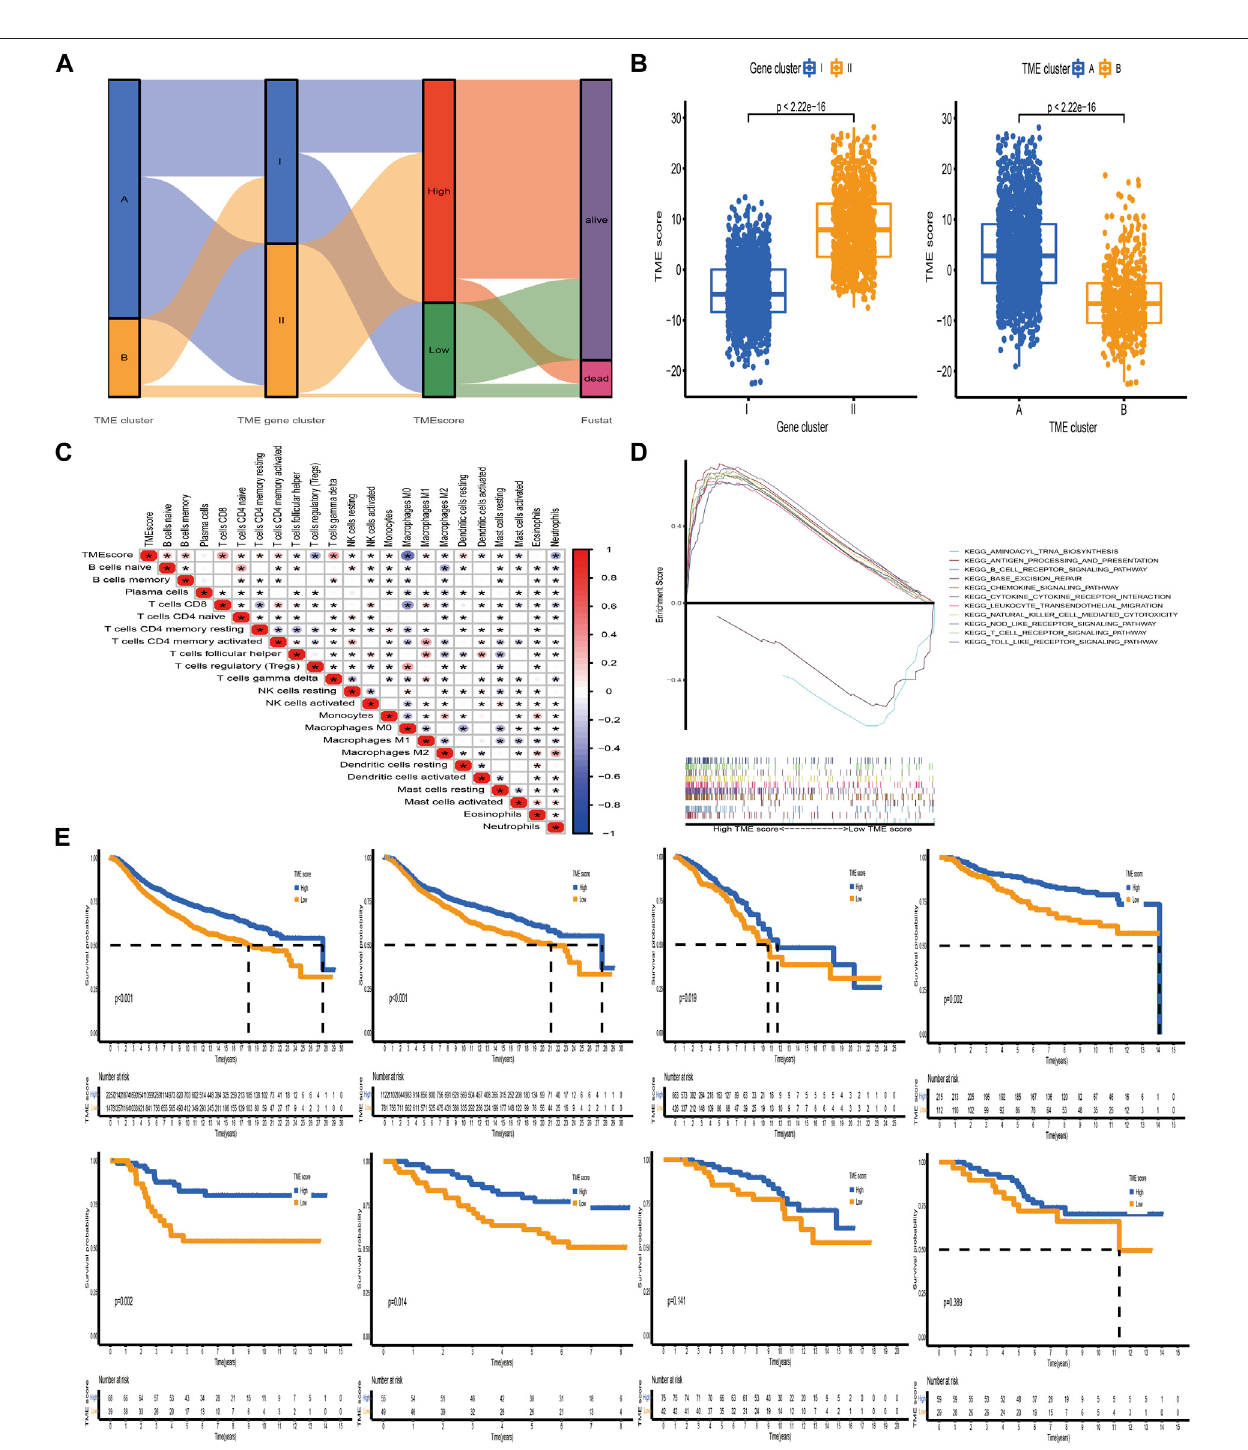
FIGURE6| ConstructionoftheTME-scoreandexplorationofitsclinicalsigni fi cance. (A) AlluvialdiagramoftheTMEcluster,TMEgenecluster,andTME-score. (B) Relative distribution ofTME-score betweendistinctTMEclustersand TMEgene clusters. (C) Correlationsbetween TME-score and tumor-in fi ltrating immunecellsusing Spearmananalysis.Theasterisksrepresentedthestatistical p -value(* p < 0.05). (D) RepresentativeresultsofKEGGpathwaysbetweenhighandlowTME-scoregroups via GSEA. (E) Kaplan – Meier curves for patients with high and low TME-score groups in the meta-cohort and METABRIC, TCGA-BRCA, GSE20685, GSE58812, GSE42568,GSE88770,andGSE20711datasets.ThemedianTME-scoreobtainedfromtheMETABRICdataset(discoverycohort)wasutilizedtoseparateBCsamples into high- and low-score groups. Independent validations were then performed using TCGA-BRCA and GSE datasets (external validation cohort).